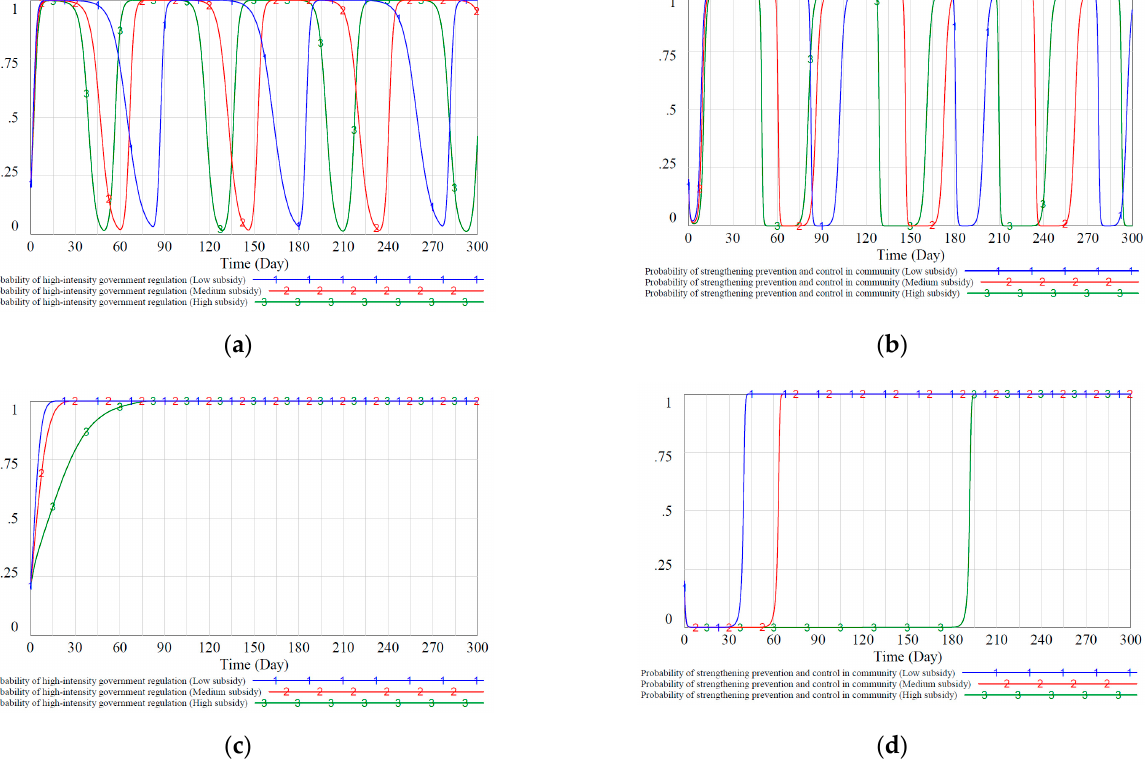
Figure 6. Proportion of the evolutionary stable equilibrium strategy of the government and the community under the static and dynamic reward and punishment mechanisms. ( a ): probability of high-intensity government regulation in different subsidy intensities under the static mechanism. ( b ): probability of strengthening prevention and control in community in different subsidy intensities under the static mechanism. ( c ): probability of high-intensity government regulation in different subsidy intensities under the dynamic mechanism. ( d ): probability of strengthening prevention and control in community in different subsidy intensities under the dynamic